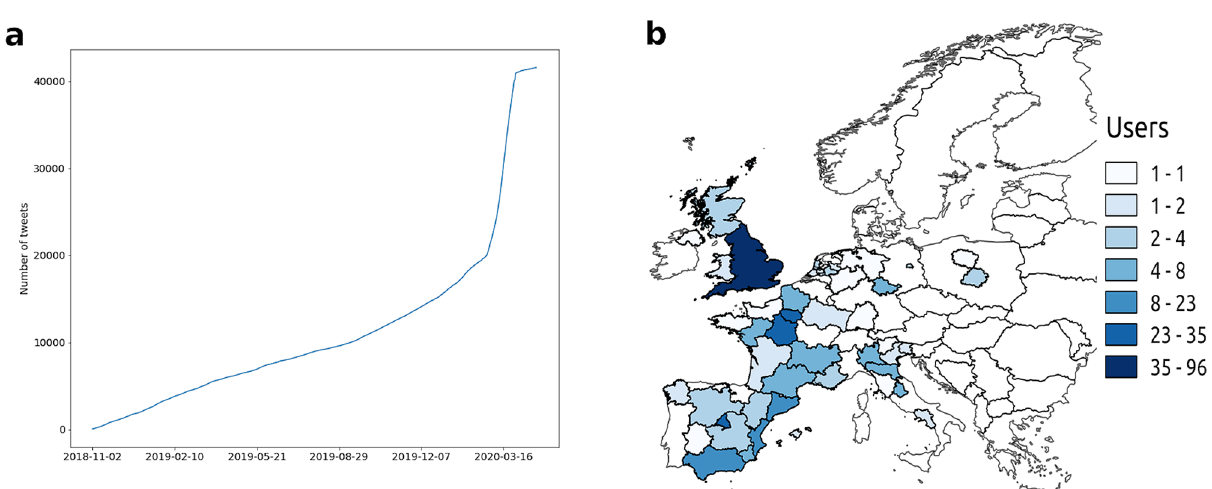
Figure 3. Anomalous evolution and geo-localization of tweets concerned with dry cough posted across Europe. ( a ) Evolution of the cumulative number of dry cough-related tweets posted in 7 European countries since November 2018. ( b ) Geographic distribution of unique users discussing dry cough in the winter season between 1 December 2019 and 30 January 2020. The map was generated using the open- source software QGIS 3.10 LTS (https